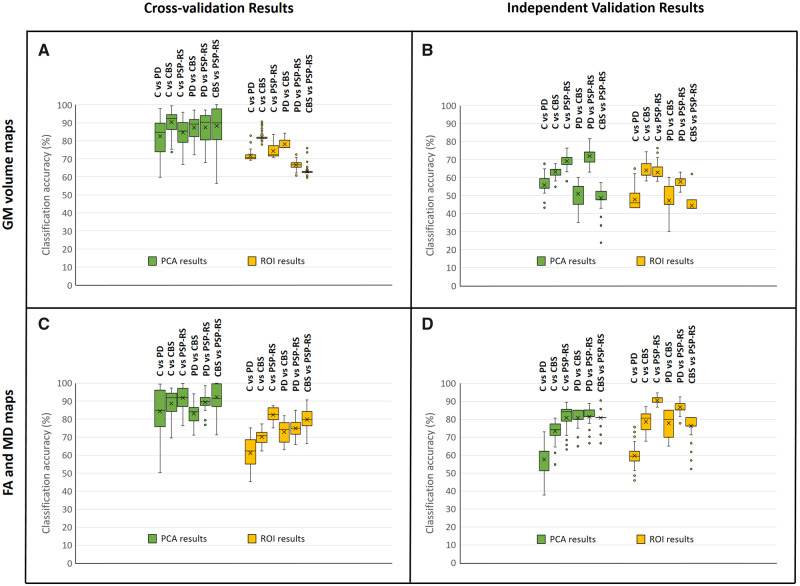

PCA versus ROIs. Comparison between feature extraction methods: PCA (green) and ROIs (yellow). The range of classification accuracies presented for each pairwise comparison and combination of methodological variables corresponds to the results obtained as different numbers of features are included in the statistical model. (A) Cross-validation results when GM volume maps are used as feature type. (B) Independent validation results when GM volume maps are used as feature type. (C) Cross-validation results when FA and MD maps are used as feature type. (D) Independent validation results when FA and MD maps are used as feature type.